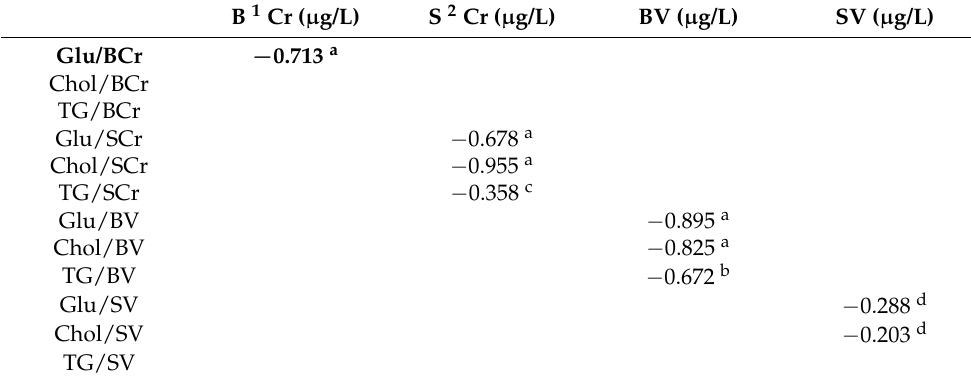
Table 3. The Pearson’s correlation coefficients and significance levels (r, p ) for the relationships between the Cr and V concentrations and biological markers (glucose, cholesterol and triglycerides) to trace elements ratios in whole blood and serum.